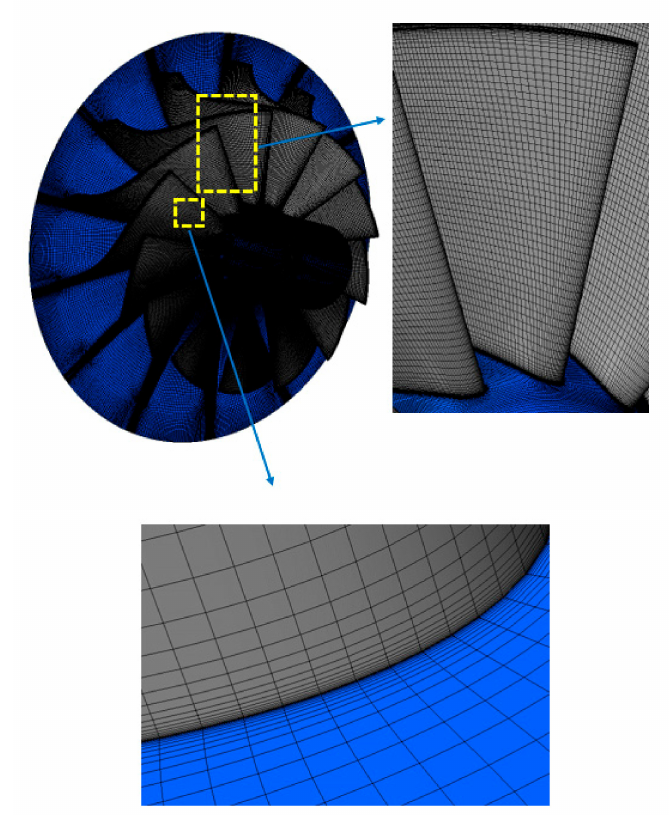
Figure 7. 3D mesh of the computational